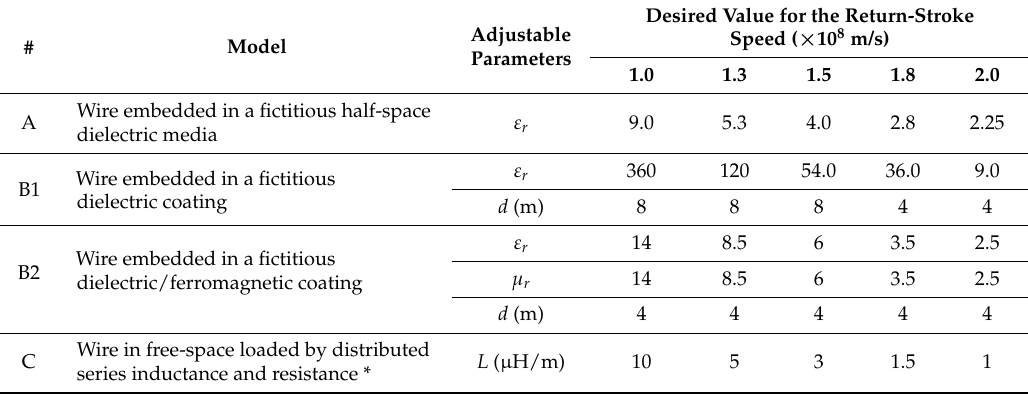
Table 5. Values of the adjustable parameters of the electromagnetic models to reproduce typically observed return-stroke